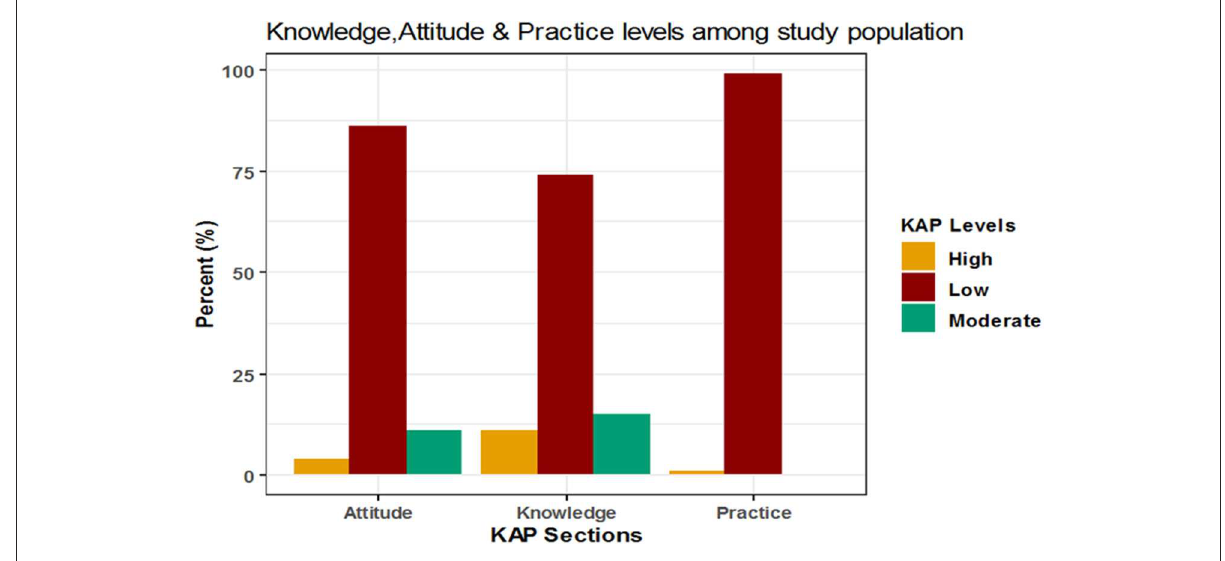
FIGURE1 Levels of knowledge, attitude and practice.